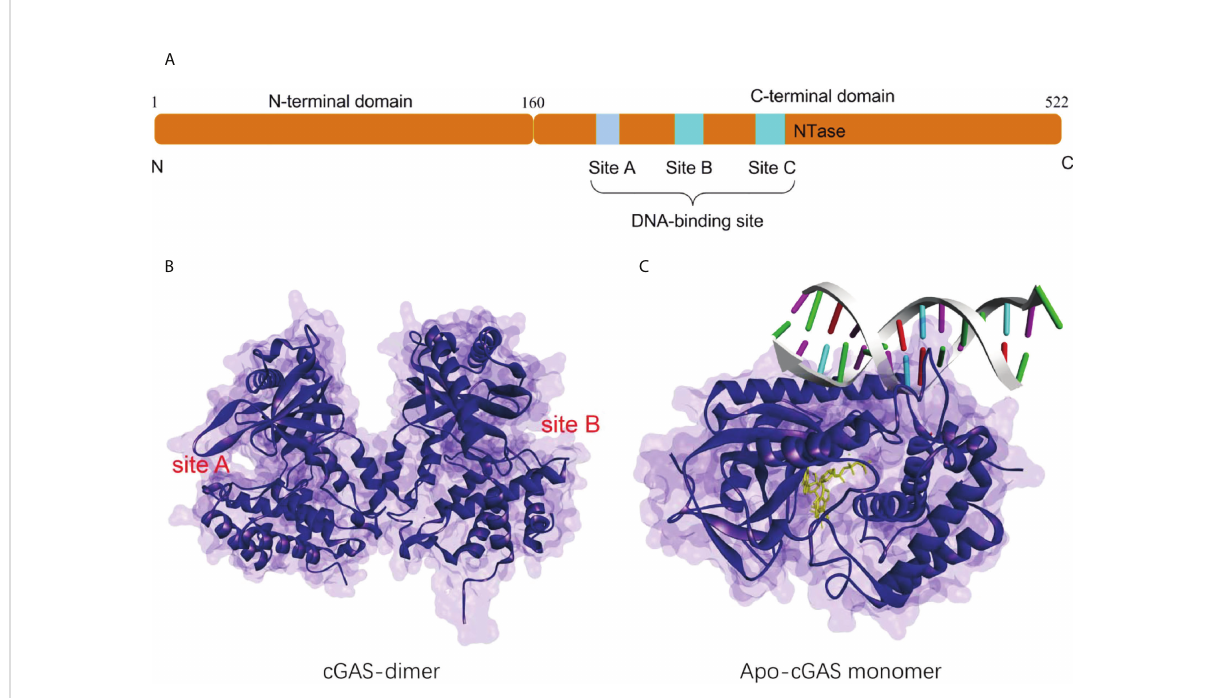
FIGURE 1 (A) Schematic organization of the structural domain of human cGAS; (B) Structure of the human cGAS dimer (PDB-ID: 4LEV); (C) Structure of porcine cGAS (blue ribbon, apo-cGAS monomer) in complex with DNA, ATP and GTP (yellow ribbon, PDB ID: